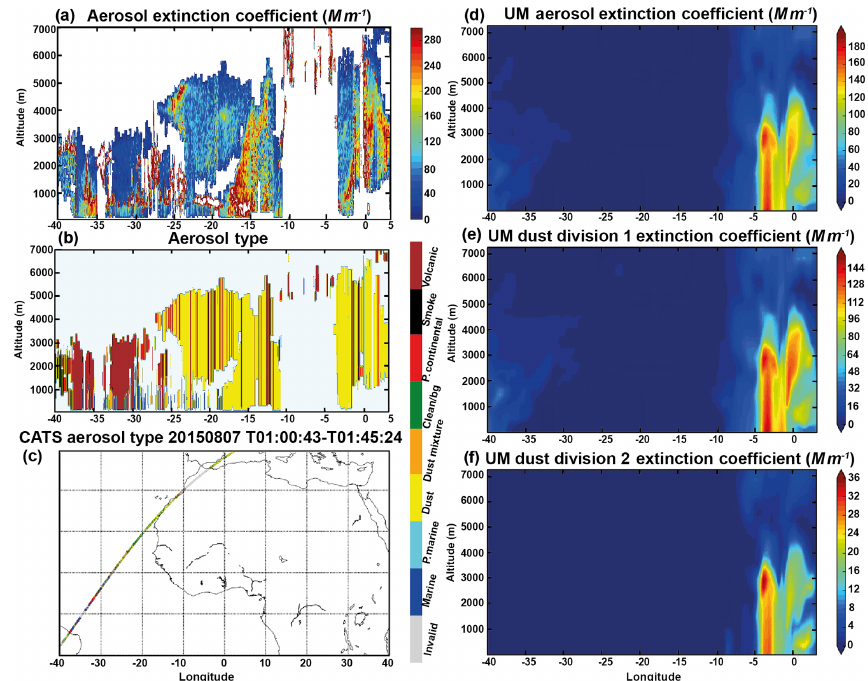
Figure 18. (a–c) CATS and (d–f) MetUM data for 18:00Z on 7 August in the form of vertical cross sections along the satellite track: (a) CATS extinction coefficient; (b) CATS feature type; (c) CATS overpass track; (d) MetUM total dust extinction coefficient; (e) MetUM d1 dust extinction coefficient; and (f) MetUM d2 dust extinction coefficient. Flight B920 is simultaneous to this satellite overpass near the Cape Verde